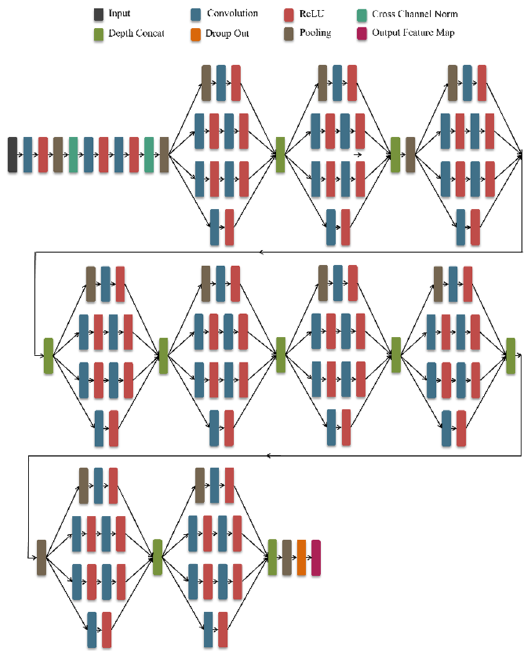
Figure 4. GoogleNet architecture.